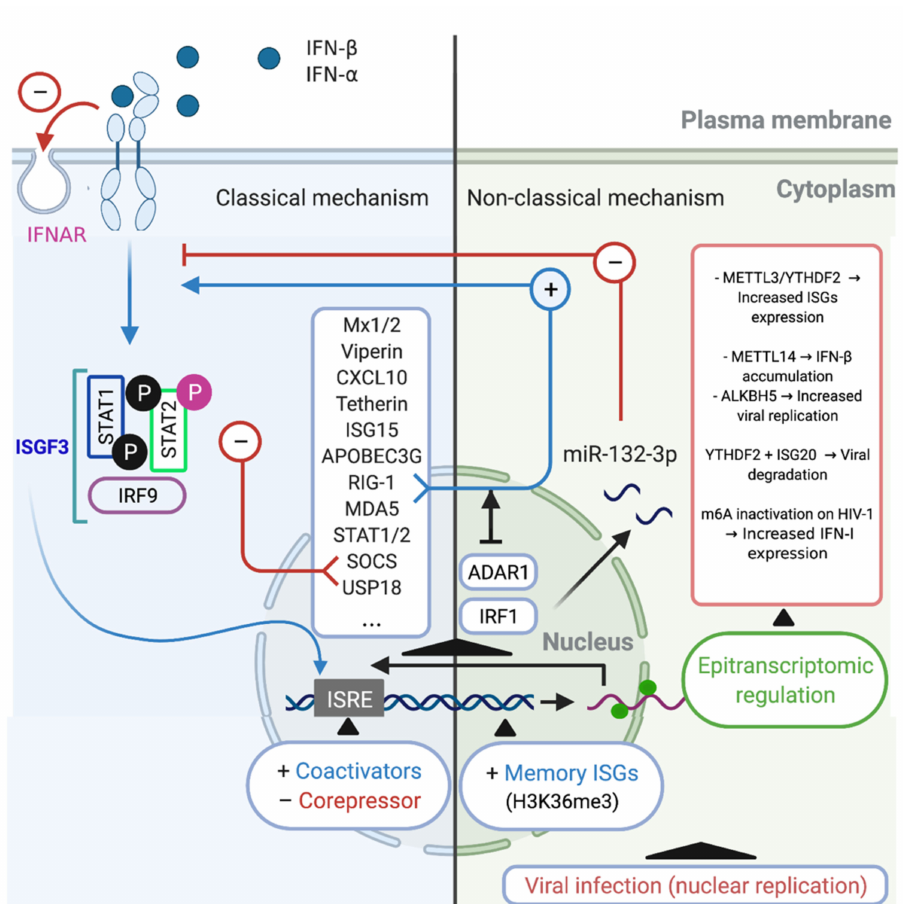
Figure 1. Classical and non-classical mechanisms of regulation of IFN/ISG signaling network. Classical regulatory mechanisms ( Left ). The type I IFN may conduce to activation of the transcriptional complex ISGF3, which is translocated to the nucleus where induces the expression of hundreds of ISGs such as Mx1/2, Viperin, CXCL10, Tetherin, APOBEC3G, RIG-1, MDA5, STAT1/2, SOCS, and USP18 [53]. SOCS and USP18 act inhibiting the IFN/ISG signaling pathway, in addition to the phosphorylation (Ser287) of STAT2 and the downregulation of cell surface IFNAR (red arrows ( − )). Another classic mechanism occurs at the transcriptional level, it is constituted by the interaction of ISGF3 with coactivators and/or corepressors that recognize ISG response elements (ISRE), modulating the expression of ISGs. Non-classical regulatory mechanisms ( Right ). One of these non-classical mechanisms is performed by ADAR1, which is an ISG that can control IFN/ISG signaling by prevent RIG-1 and MDA5 sensing of viral RNAs (blue arrow (+)). Another non-classical mechanism is performed by miR-132-3p, which negatively regulates the IFN/ISG signaling interfering with the gene expression of IRF1 (red arrows ( − )). Another example of non-classical regulation of IFN/ISG signaling is performed by an epigenetic mechanism, called “innate memory”, which favors an accelerated recruitment of RNA polymerase II and transcription/chromatin factors associated via H3K36me3, promoting mRNA transcription of associated molecules of the IFN/ISG signaling pathway. Finally, a recently described non-classical mechanism of regulation of IFN/ISG signaling pathway, involves the epitranscriptomic regulation through of the m6A-machinery, controlling the fate of IFN and ISG mRNAs for degradation or translation [115,126–128]. Figure created with Biorender.com (accessed on 15 July